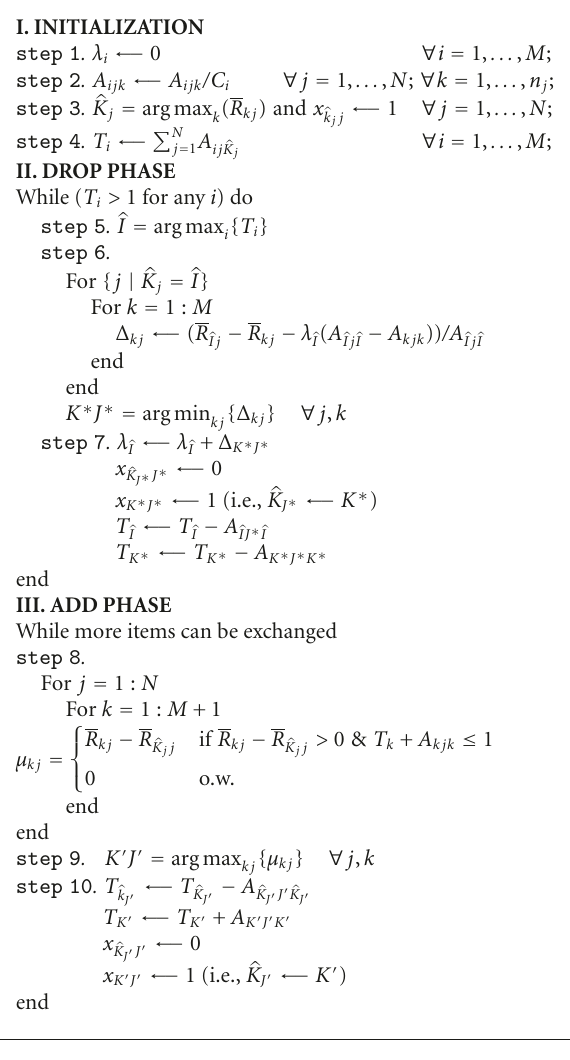
Algorithm 1: MMKP algorithm for resource allocation in multi- hop